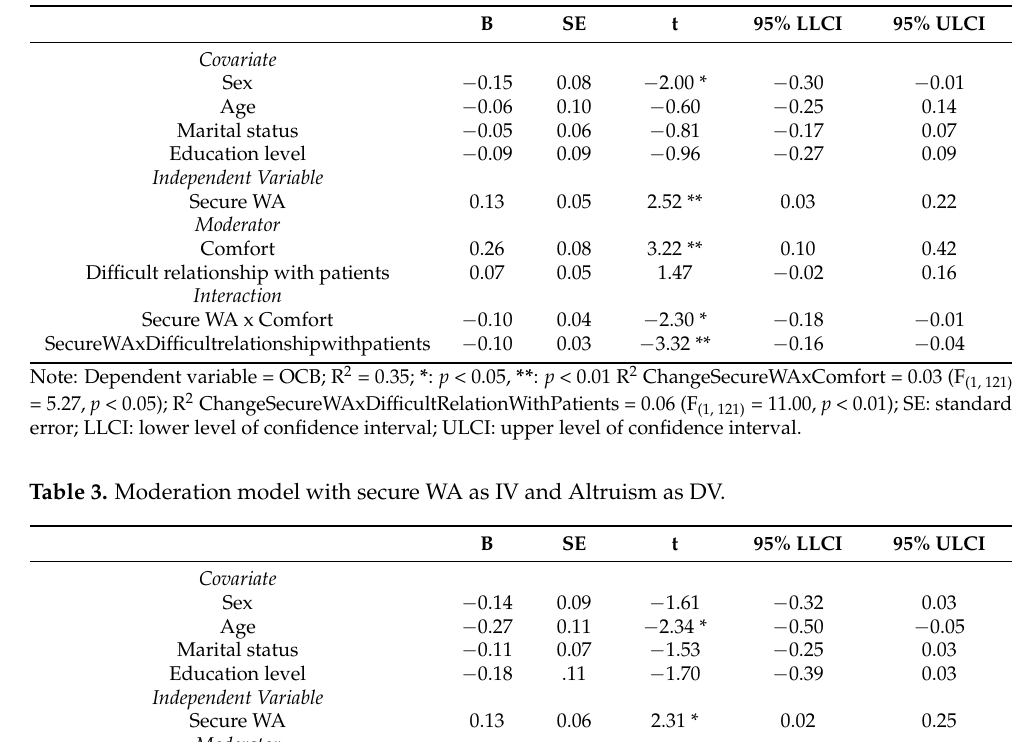
Table 2. Moderation model with overall OCB as DV.